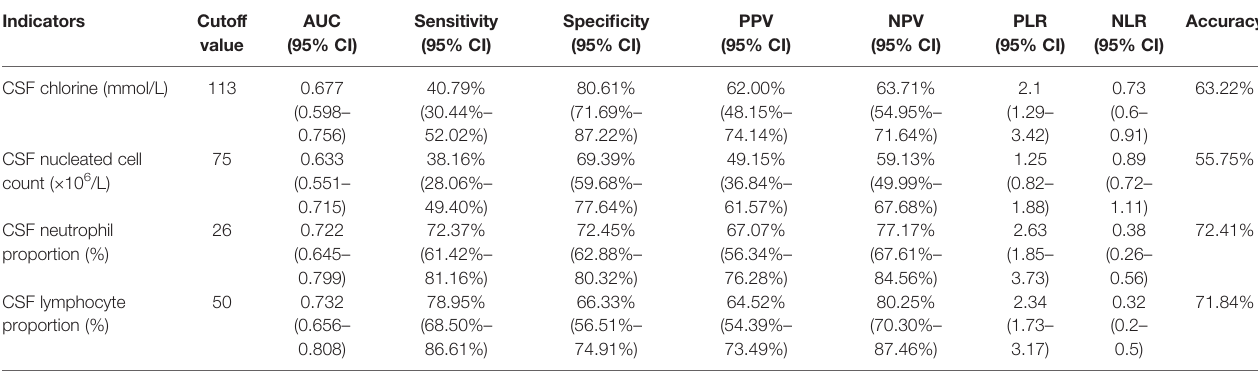
TABLE 2 | The performance of CSF indicators for differentiating TBM from